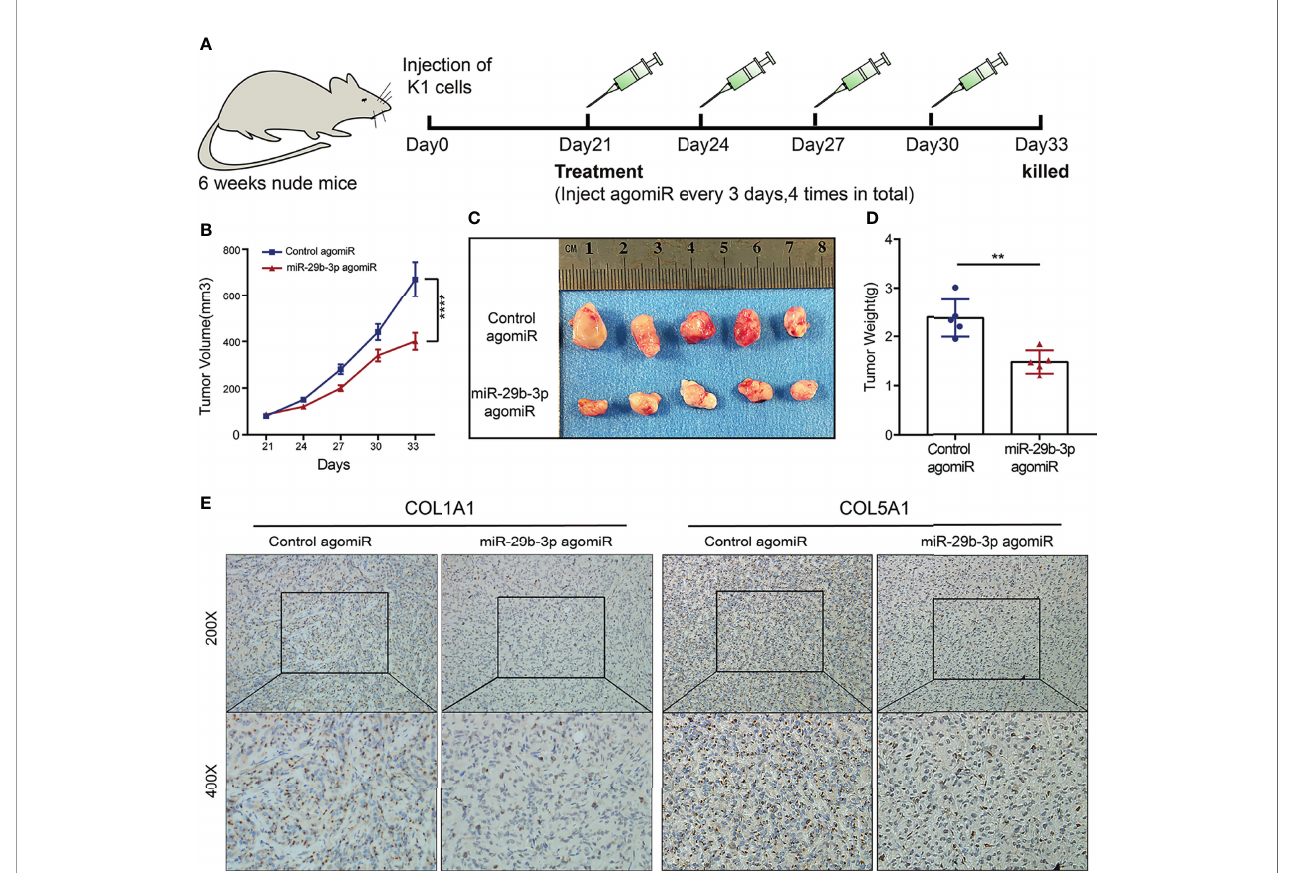
FIGURE 6 | miR-29b-3p inhibits PTC cell growth and decreased COL1A1 and COL5A1 expression in vivo . (A) Schematic diagram of the in vivo experimental process. (B) Tumor growth curves of control agomiR (n = 5) and miR-29b-3p agomiR (n = 5) in nude mice. (C) Gross pathology of tumors at post-transplanted day 33. (D) Statistical analysis of the mean tumor weight of tumor xenografts from nude mice after 33 days of treatment. (E) Immunohistochemistry analysis of protein expression levels of COL1A1 and COL5A1 in tumor xenografts treated with miR-29b-3p agomiR and control agomiR. In the fi gure, **p < 0.01, ****p <